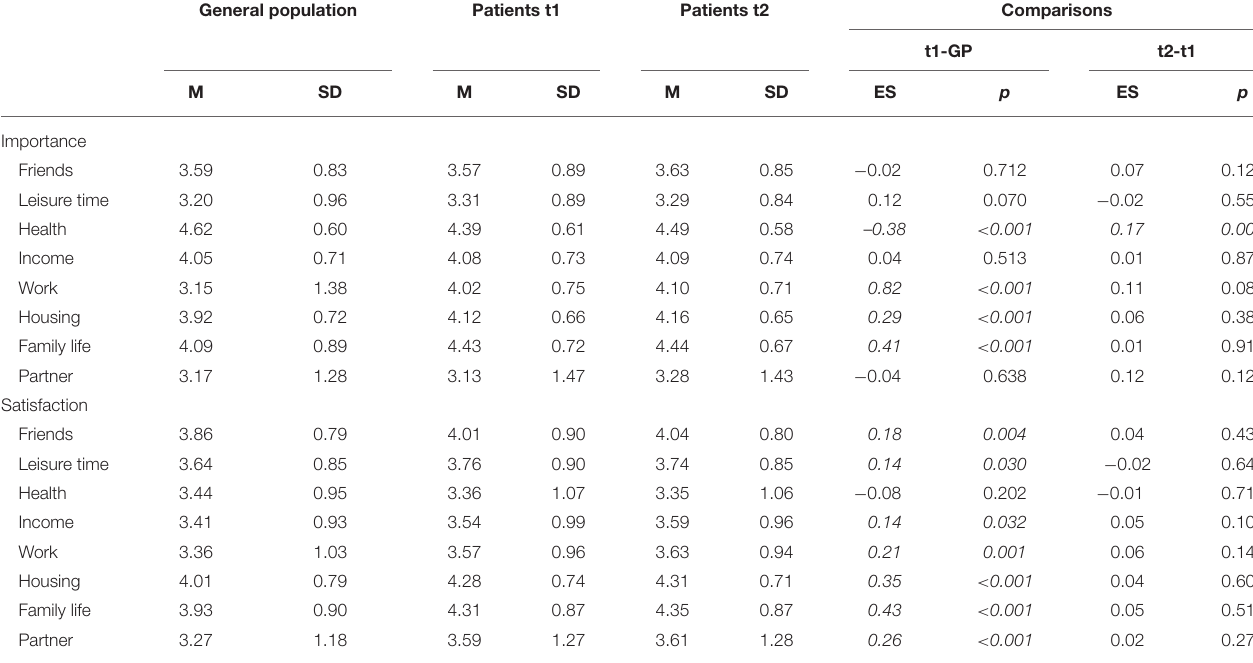
TABLE 2 | Importance and satisfaction ratings (range: 1–5). General population